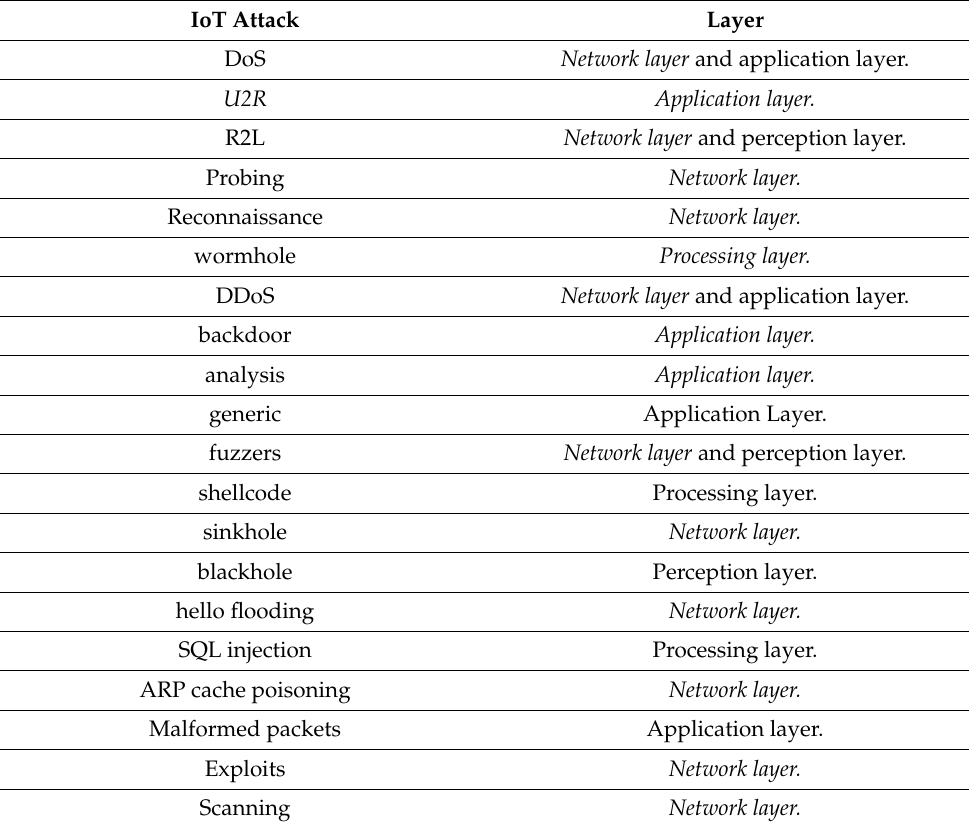
Table 9. IoT attacks according to the